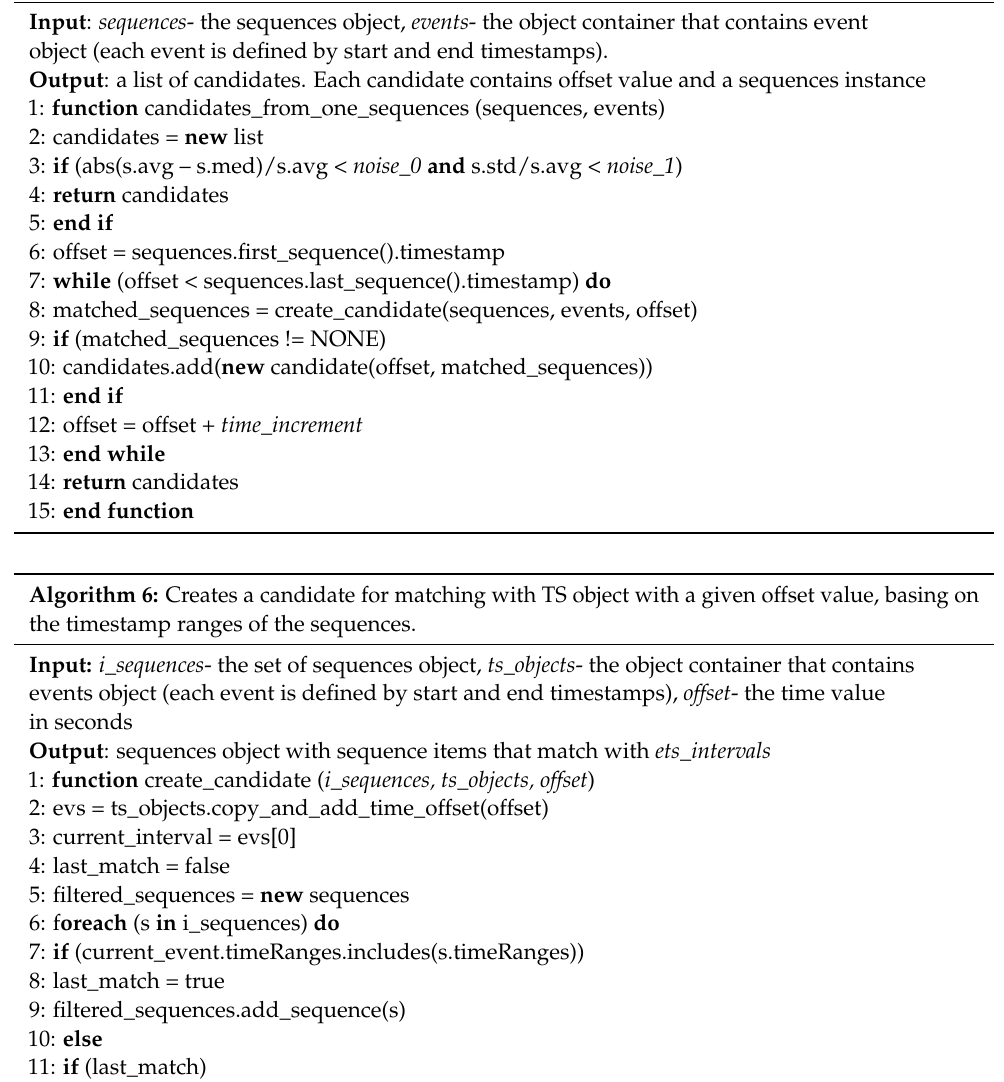
Algorithm 5: Creates candidates list from one sequences object instance.